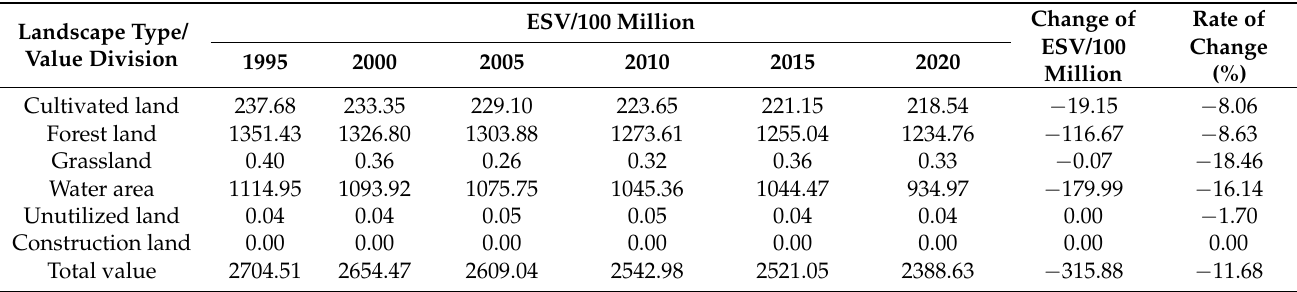
Table 2. Structure and corresponding changes of ecosystem service value (ESV) in the Dongting Lake area from 1995 to